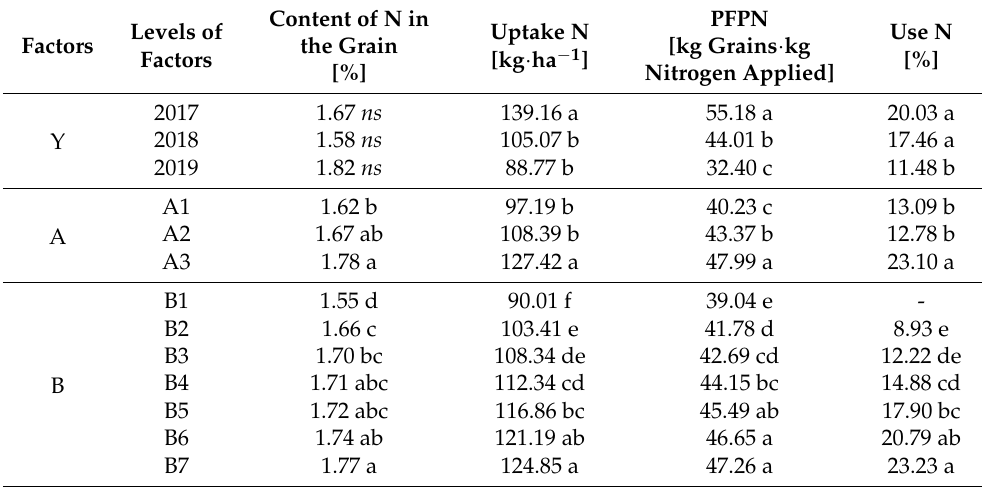
Values in columns marked with at least one same letter are not significantly different; ns —not significant.